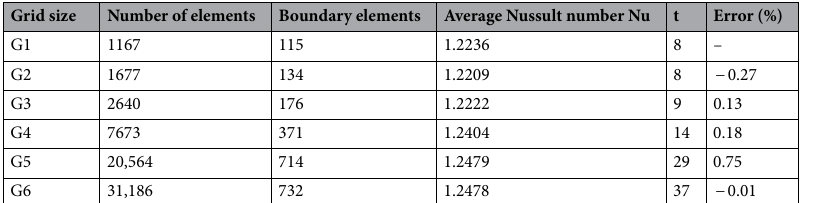
Table 3. Grid testing for average Nussult number on hot surface (Ra = 10 6 , λ = 0.52, and γ = 45°).